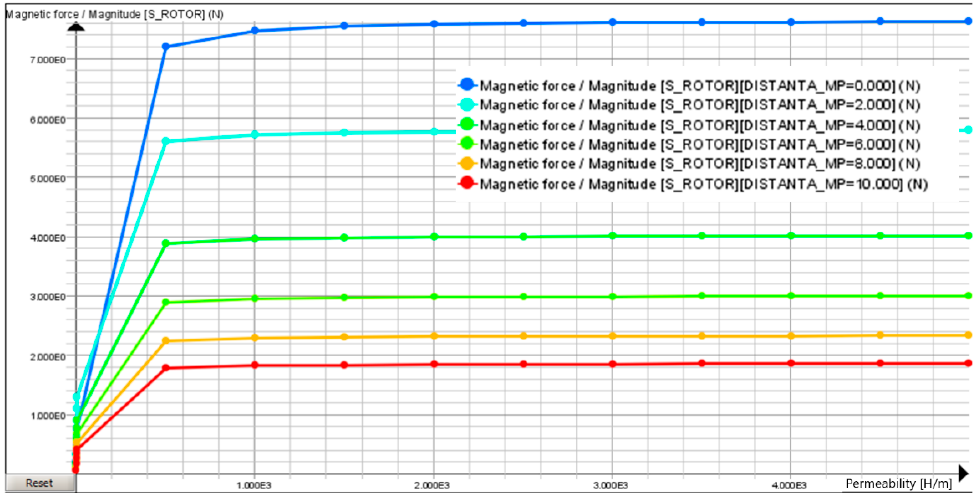
Figure 20. Variation of the magnetic force of attraction when changing the permeability of gadolinium and the distance (=DISTANTA) between permanent magnets—2D representation.